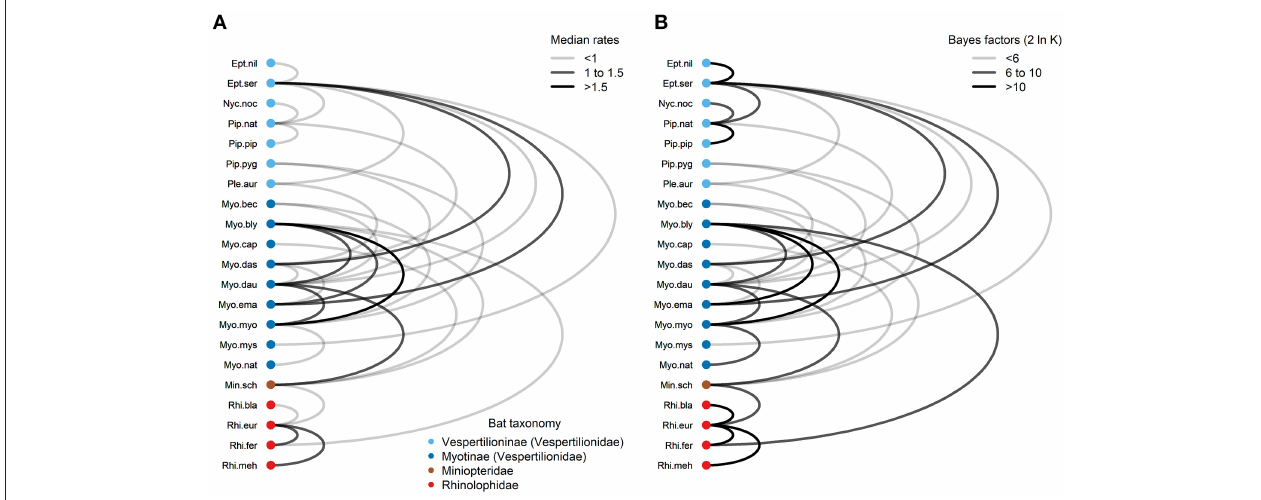
FIGURE 6 | Graph of Bartonella transition rates among European bat species. (A) Transition rates (median of the posterior distribution) with significant Bayes factors (BF > 3) are drawn as edges connecting nodes representing bat species. (B) Bayes factors are plotted as 2 ln K , where K is the Bayes factor support. Nodes were colored according to bat families/subfamilies. Edge colors were scaled according to median transition rates in (A) or Bayes factor support in (B) . Details of transition rates and Bayes factor calculations can be found in Table S17 . Species abbreviations for bat species are listed in Table 1 .